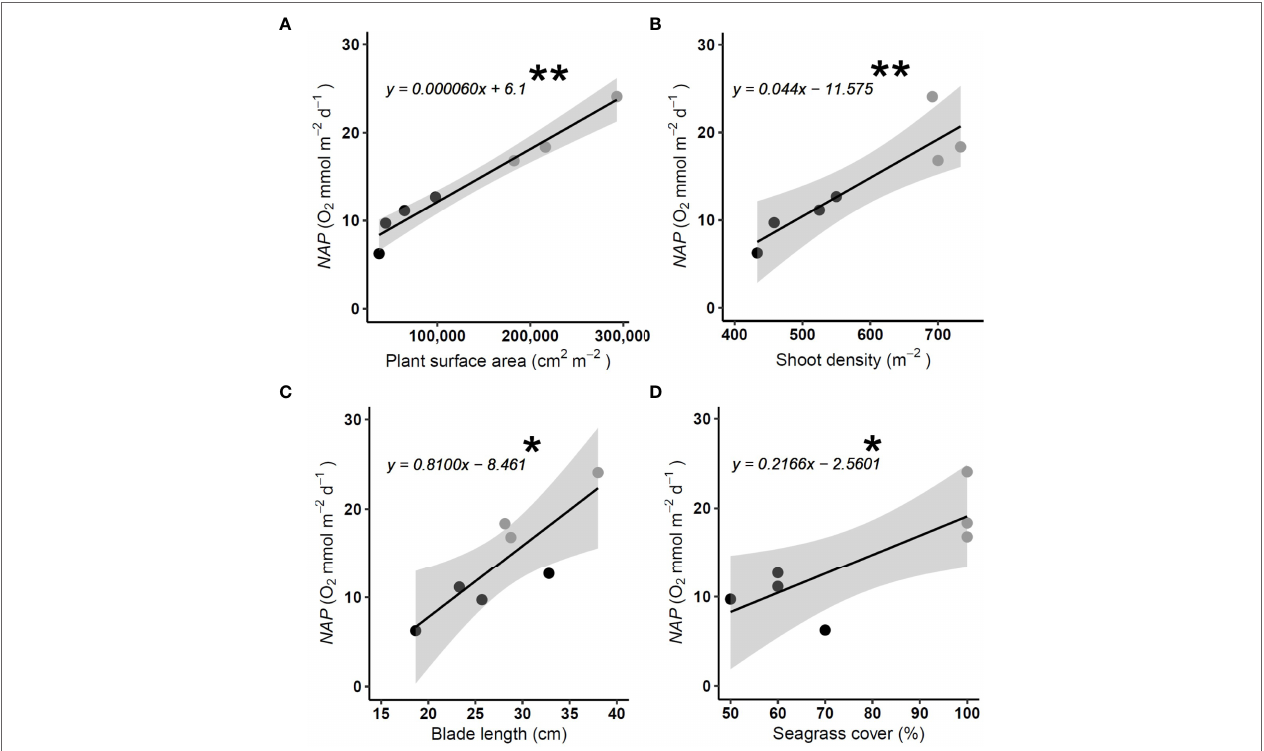
FIGURE 6 | Net apparent productivity (NAP) of P. oceanica meadow edge (Black) and meadow center (grey) determined in Summer with large benthic chambers, in relation to (A) P. oceanica blade surface area (B) P. oceanica shoot density (m-2) (C) P. oceanica blade length (cm) and (D) P. oceanica cover (%). Central meadow n = 3, meadow edge n = 4. Significant linear regression from edge and central meadow combined * = P < 0.05, ** = P < 0.01. Grey bands reflect the 95% confidence level interval for predictions from a linear